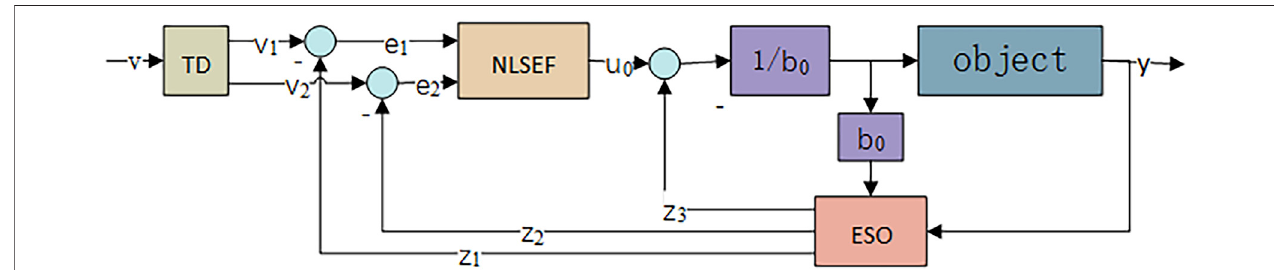
FIGURE 2 | ADRC controller structure.